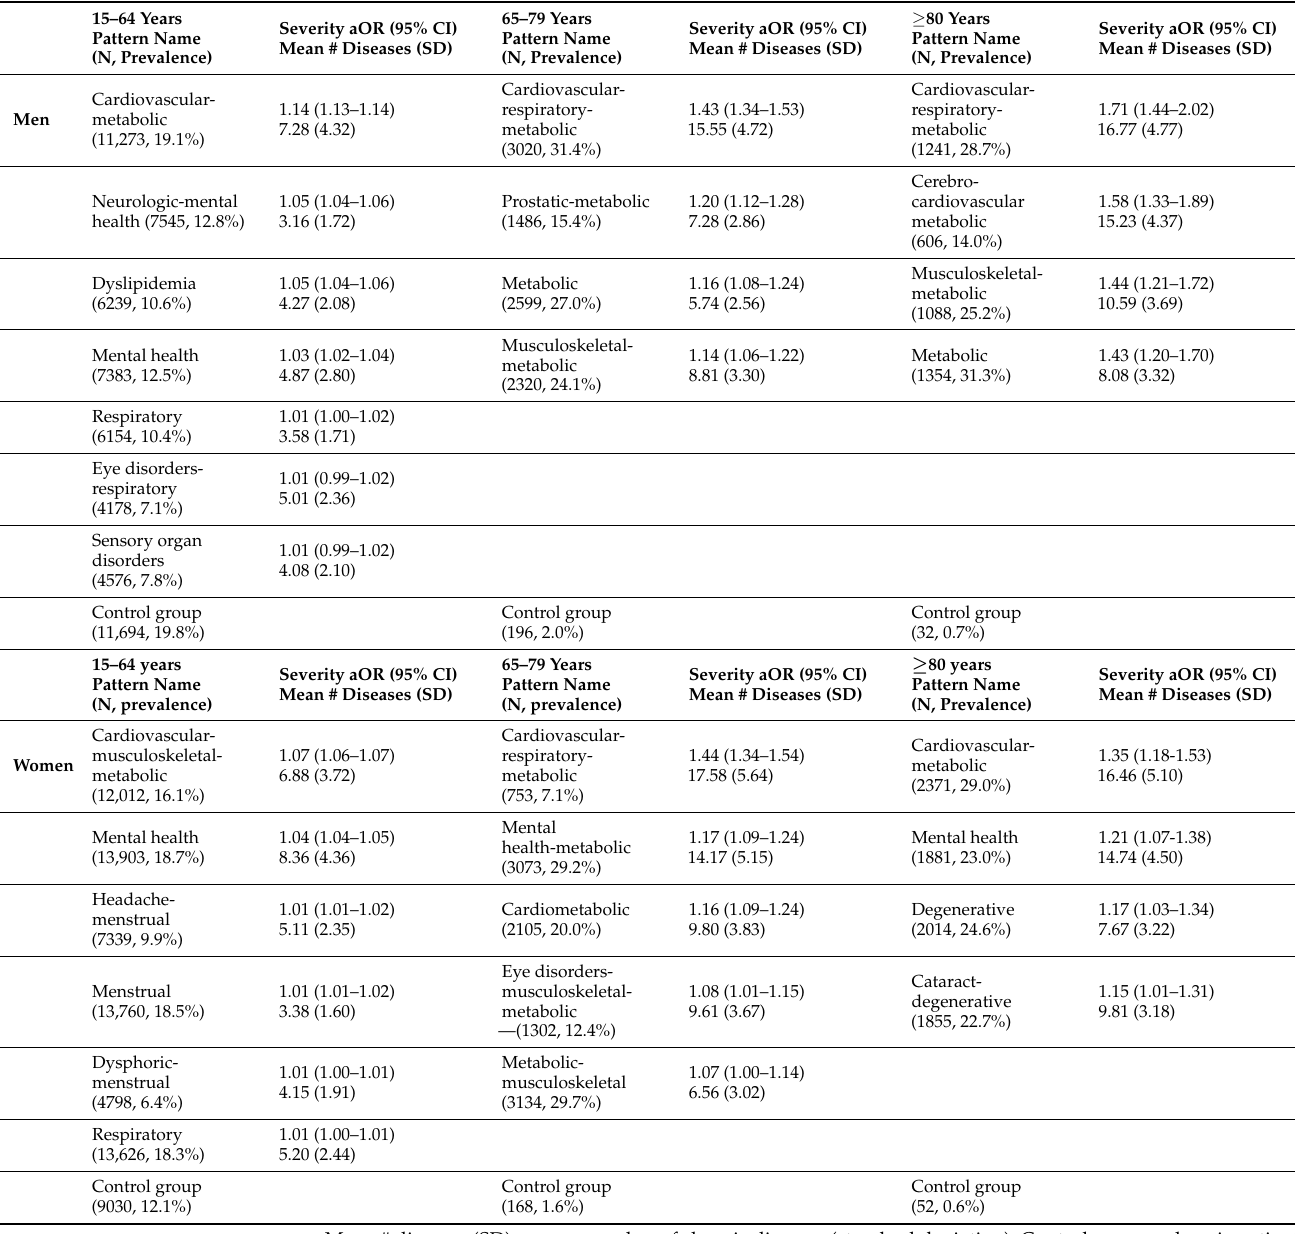
Table 2. Denomination and prevalence of multimorbidity patterns found in COVID-19 patients based on sex and age and their age-adjusted odds ratios (aORs) of infection severity compared with chronic patients without